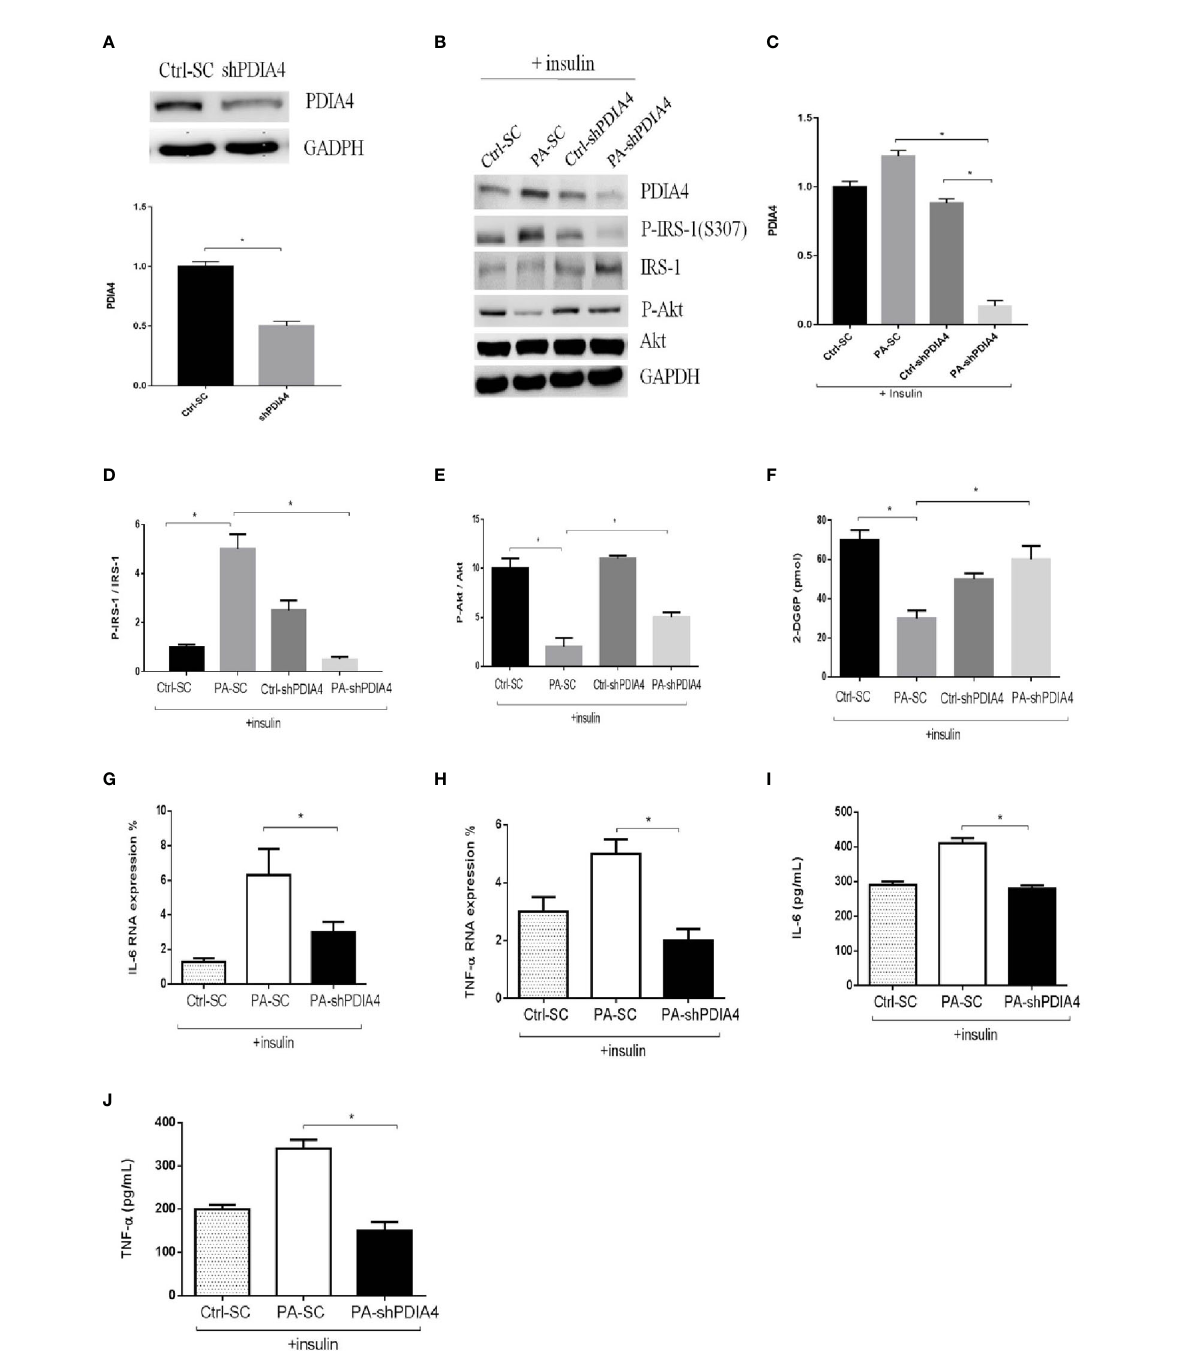
FIGURE 3 Knockdown PDIA4 inhibited palmitate induced IR, in fl ammatory cytokines and increased glucose uptake in C2C12 cells. (A, B) The protein levels of PDIA4 in C2C12 myotubes stably transfected with scrambled control (SC) or shRNA against PDIA4 (KD) were tested by western blot. (C-E) Knockdown PDIA4 in C2C12 myotubes, and treated with 0.6 mM of palmitate (PA) with 100 nM insulin, then estimated p-IRS-1(307), p-Akt by western blotting. (F) 2-Deoxyglucose (2-DG) uptake was assessed. The levels of (G, H) IL-6, TNF- a were analyzed by real-time PCR, (I, J) IL-6, TNF- a were analyzed by ELISA. All data are presented as the mean ± SD (n = 3 for each group); *P <